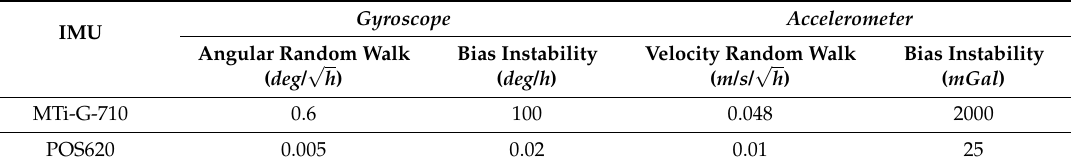
Table 1. The technical parameters of MTi-G-710 and POS620.